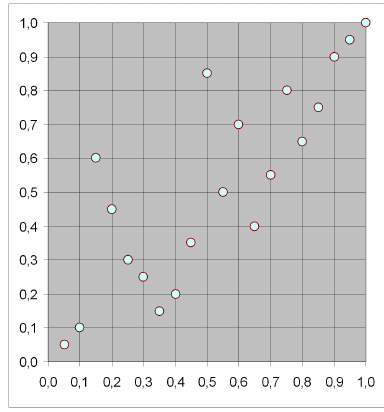
Figure 5: Relative ranks r · i /20 Figure 6: Shuffle of M with local upper Fréchet